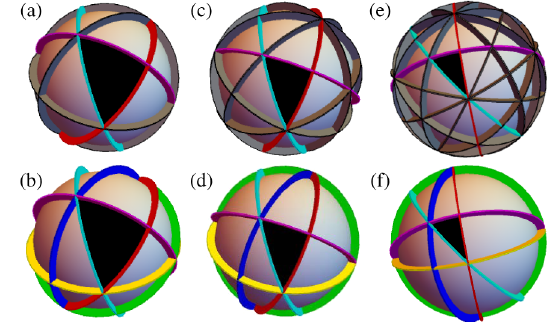
FIG. 3. The top row [(a),(c),(e)] depicts the arrangement of the λ 0 reflection planes (gray and colored disks) and the tiling of sphere into G spherical triangle sectors for A 3 , C 3 , and H 3 , respectively. The bottom row [(b),(d),(f)] shows the coincidence planes (colored disks) for specific, nonsymmetric choices of masses within the mass families for A 3 , C 3 , and H 3 , respectively. The disk colors are the same as in Fig. 1. The black spherical triangle tiles the sphere in the top figure and it is similar to the integrable sector Ω 1234 in the bottom figure. This sector is bounded by the planes Z 12 (red), Z 23 (cyan), Z 34 (magenta), which are the generating planes for the Coxeter